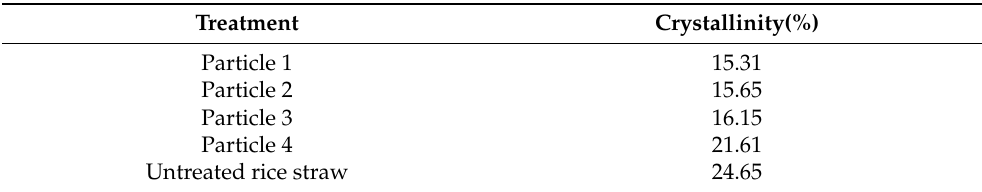
Table 2. Crystallinity index at different particle size groups after the hydrolysis and acidification process.